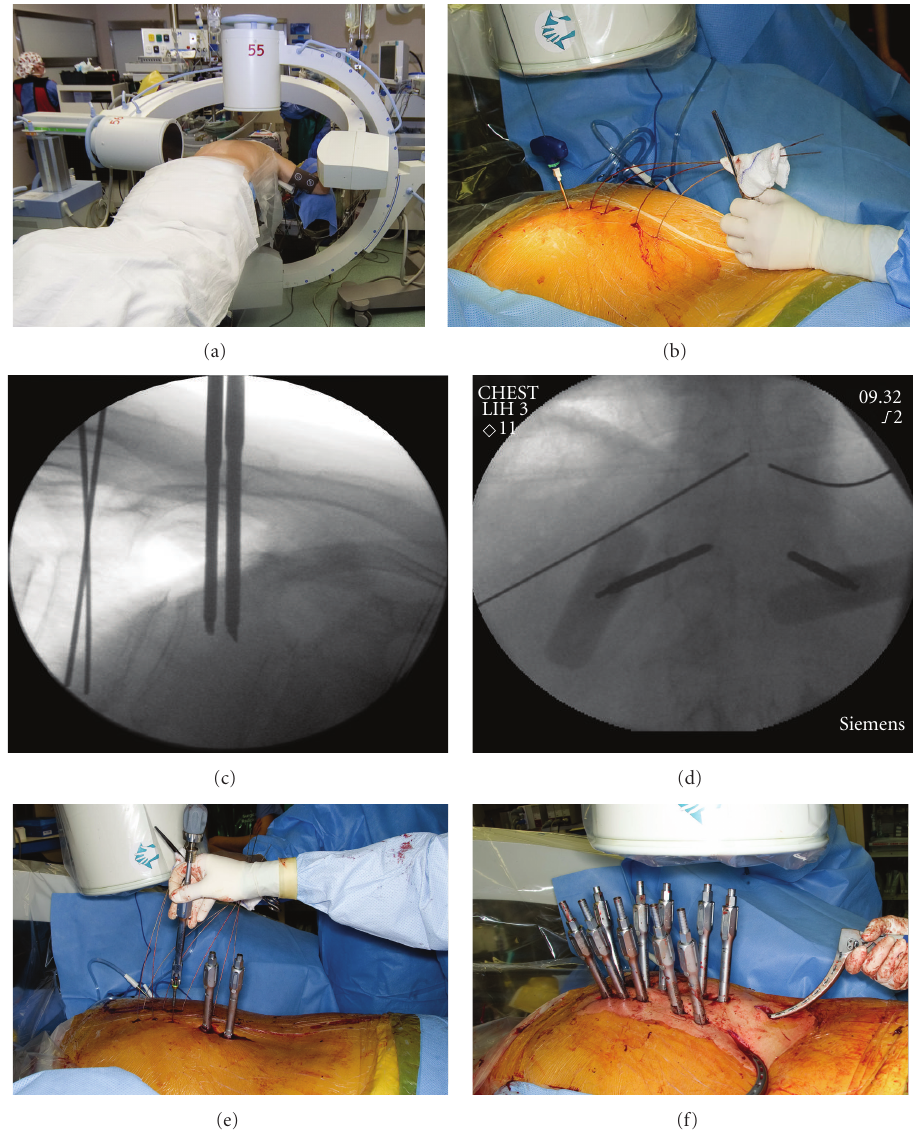
Figure 1: Percutaneous pedicle screw instrumentation. (a) Dual fluoroscopy setup; (b) percutaneous cannulation of pedicles; (c, d) lateral and anteroposterior imaging of pedicle cannulation; (e) passage of pedicle screws; (f) percutaneous passage of rod.